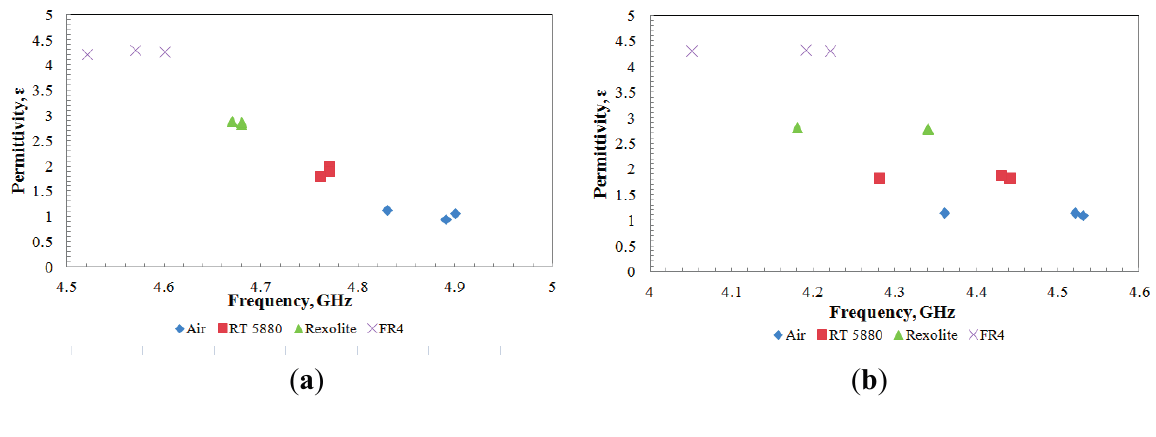
versus resonant frequency, f for ( a ) aligned-gap r